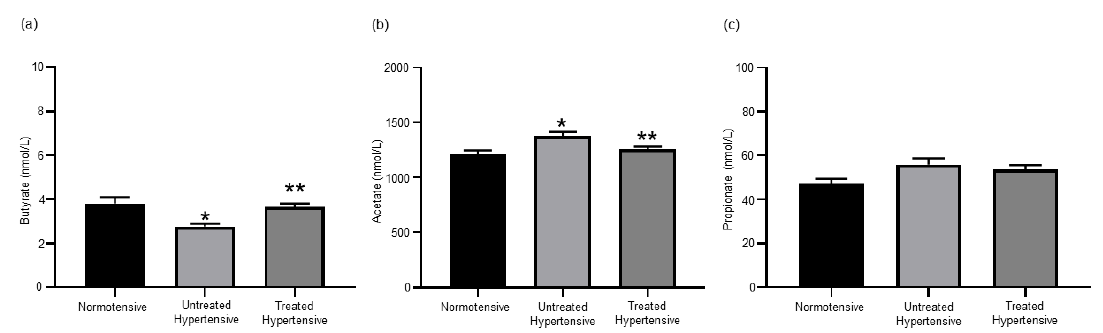
Figure 1. Short chain fatty acid serum levels were altered in response to antihypertension